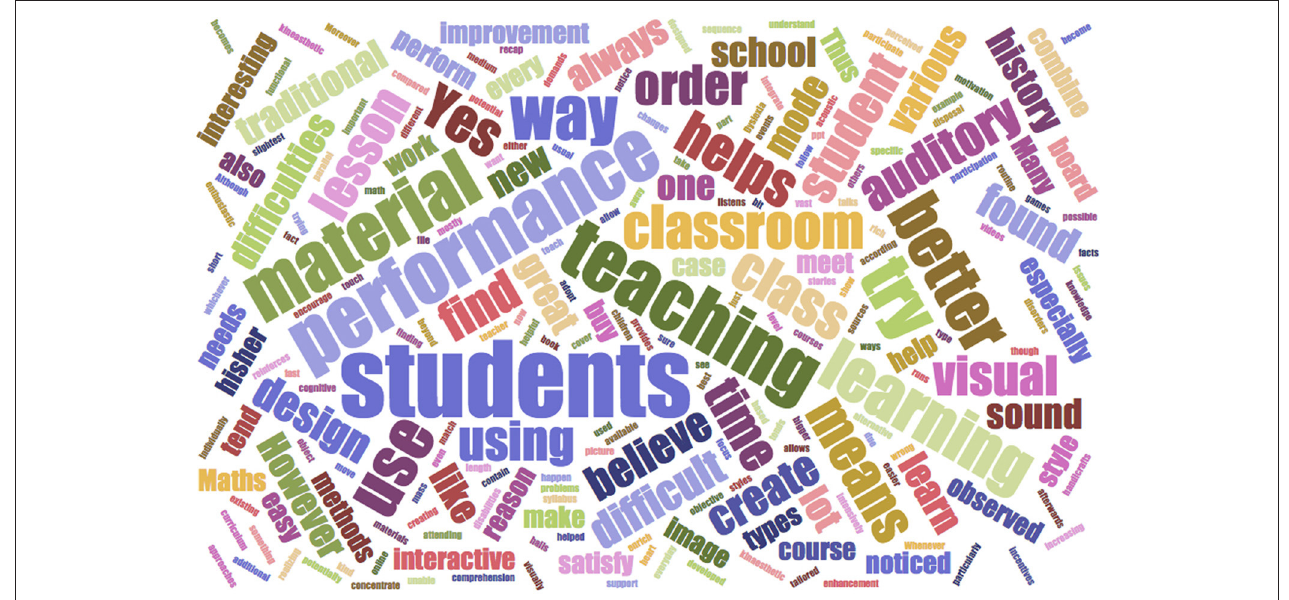
FIGURE 1 | Word cloud representing the most frequent words, giving greater prominence to words that appear more frequently, in the teachers’ responses to the open-ended question: “Does teaching that is tailor made to the students’ learning styles reinforce the students’ performance?”.